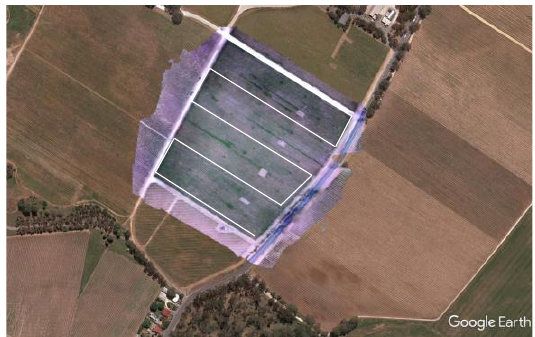
Figure 2: Orthomosaic view of the VIS dense point cloud superimposed onto a Google Earth extract of the Jacobs Creek site at 34° 34’ 04’’ South, 138° 56’ 00’’ East. The white lines depict the approximate ‘lawn mower’ flight.